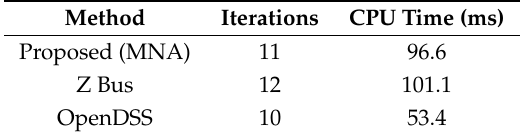
Table 2. Performance of the different methods in terms of convergence for the IEEE 8500-node